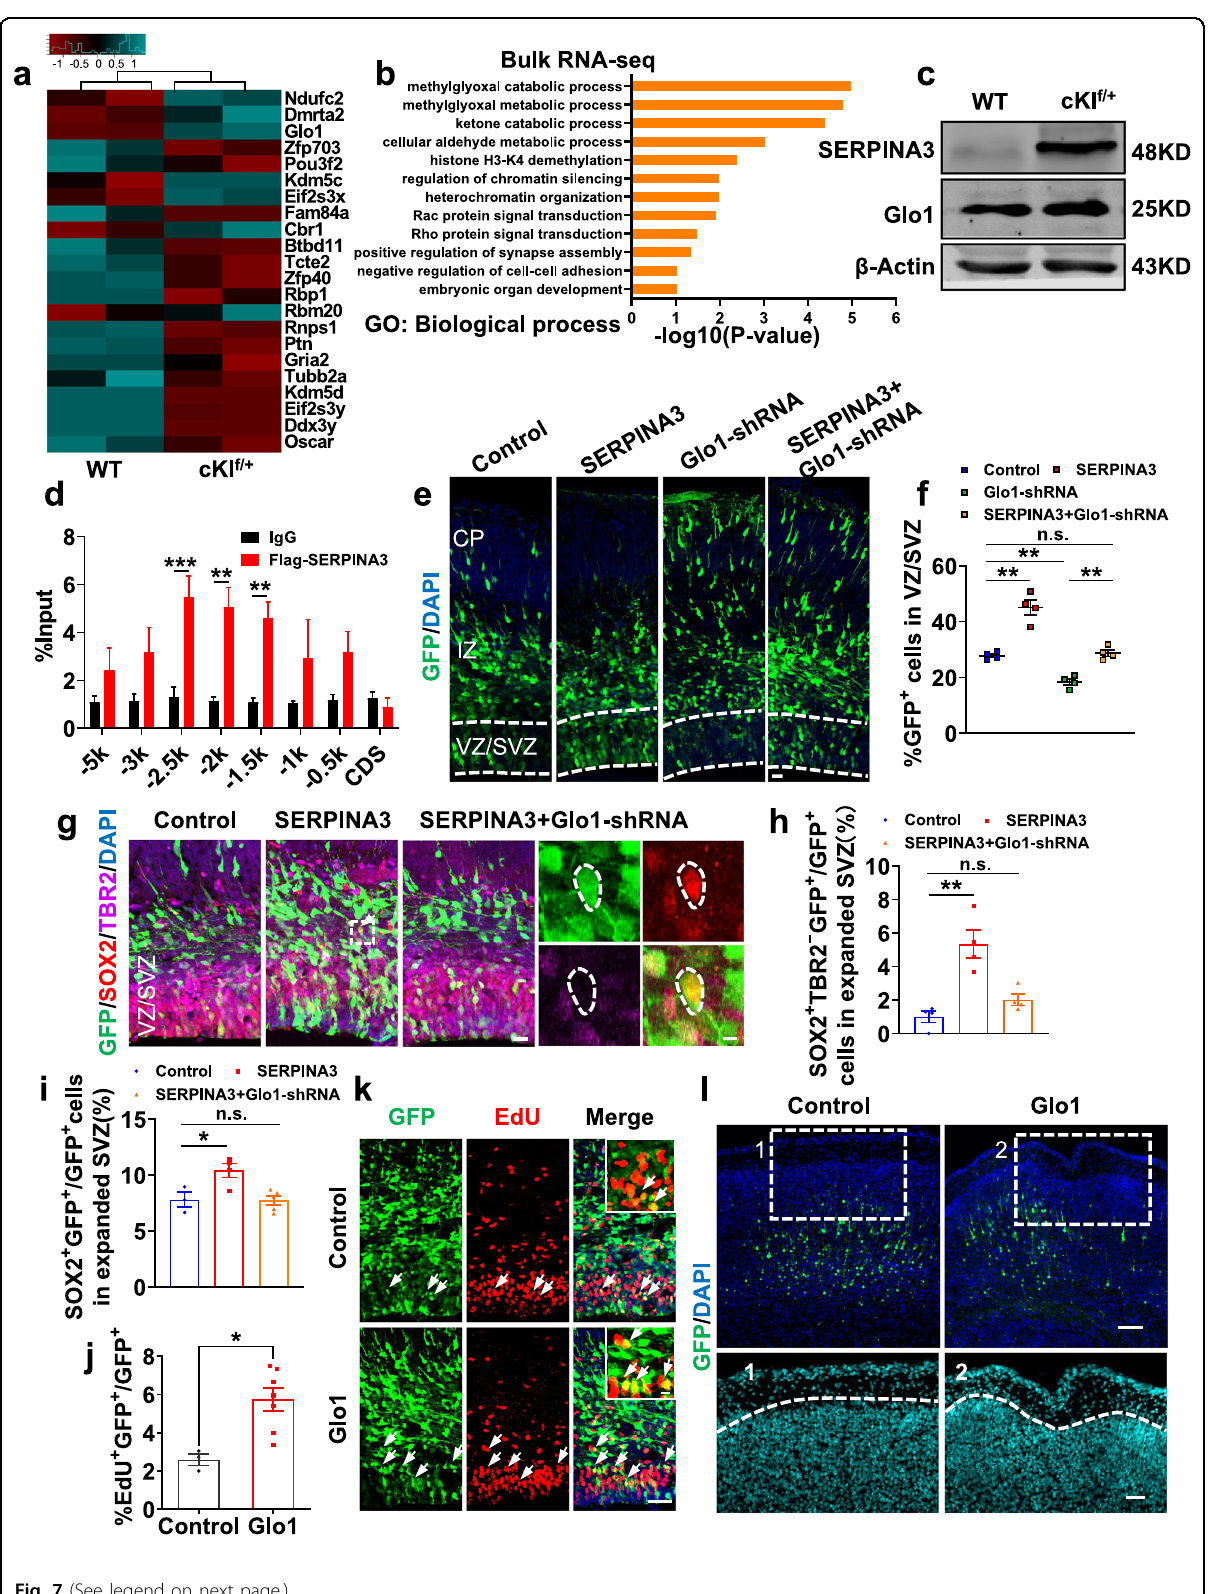
Fig. 7 (See legend on next